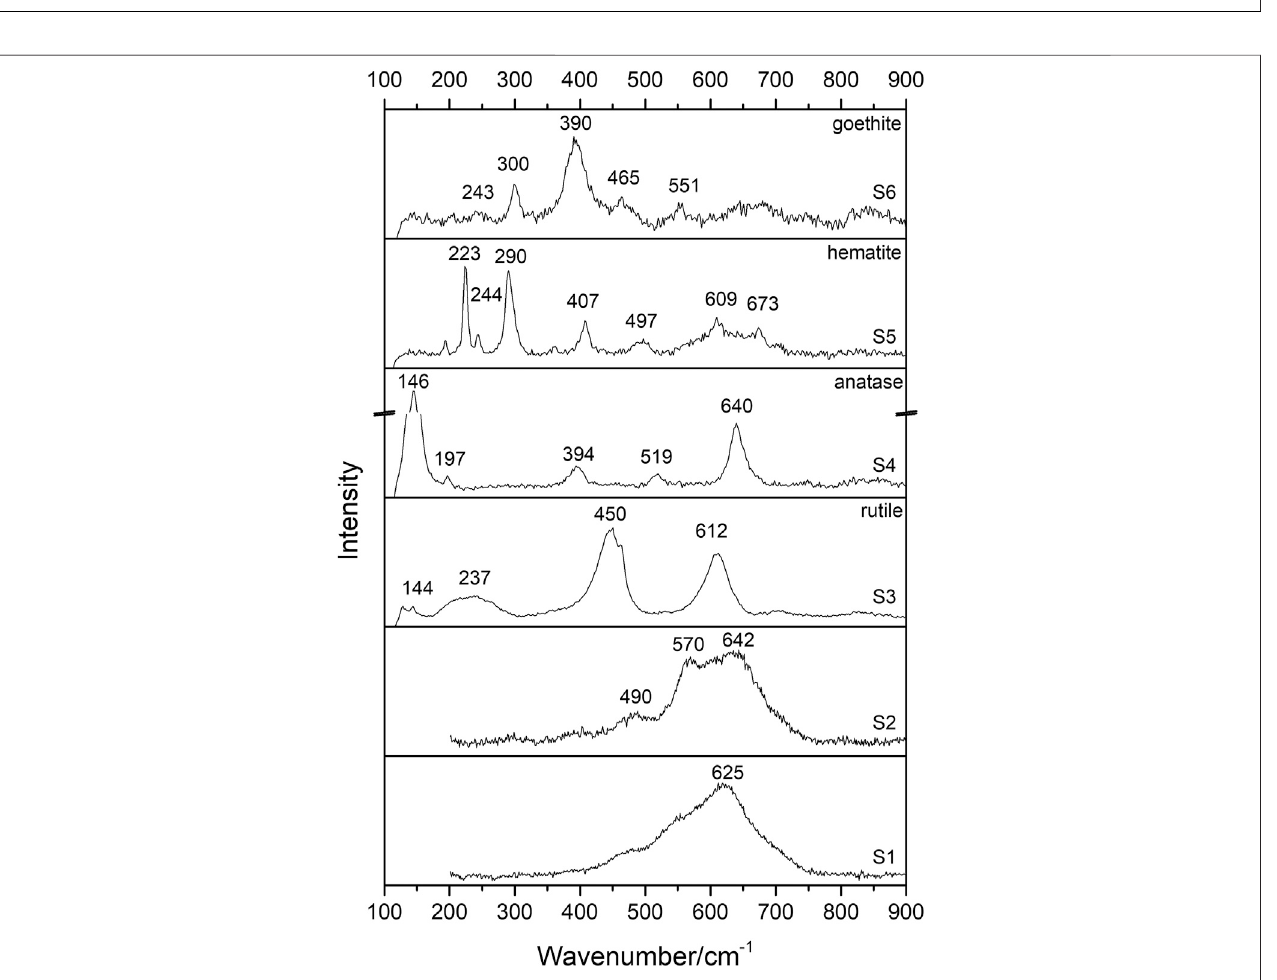
FIGURE 6 | | Raman spectra collected on black layers (spectra S1, and S2) and brown lenses (spectra S3, S4, S5, and S6). Spectra collected at λ (cid:2) 532 nm.